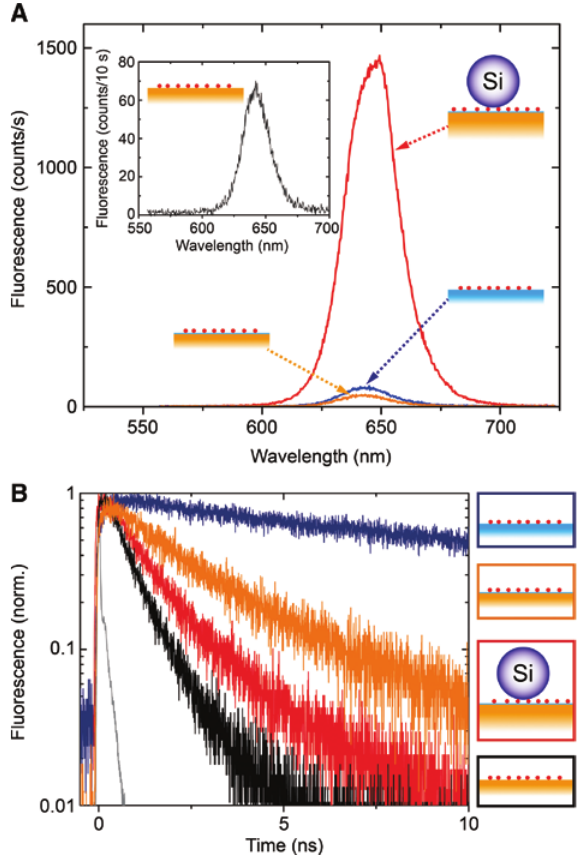
Figure 4: Enhancements of spontaneous emission intensity and decay rate. Photoluminescence enhancement (A) and emission decay (B) from a SiNPoM antenna compared with samples as control references. Red: quantum dots coupled to a SiNPoM antenna; Blue: quantum dots on glass; Yellow: quantum dots on a gold film with 5 nm Al spacing layer; Black: quantum dots on a bare gold film; Grey in (B): Instrument response